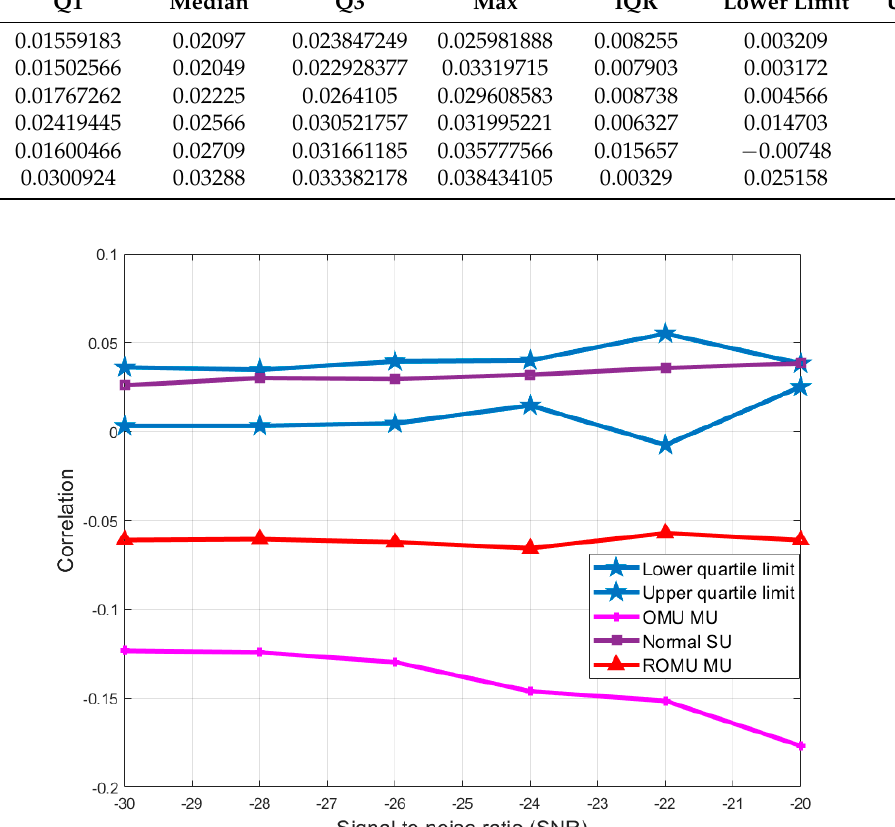
Table 4. Box-whisker plot data of the correlation results under both OMU and ROMU users.